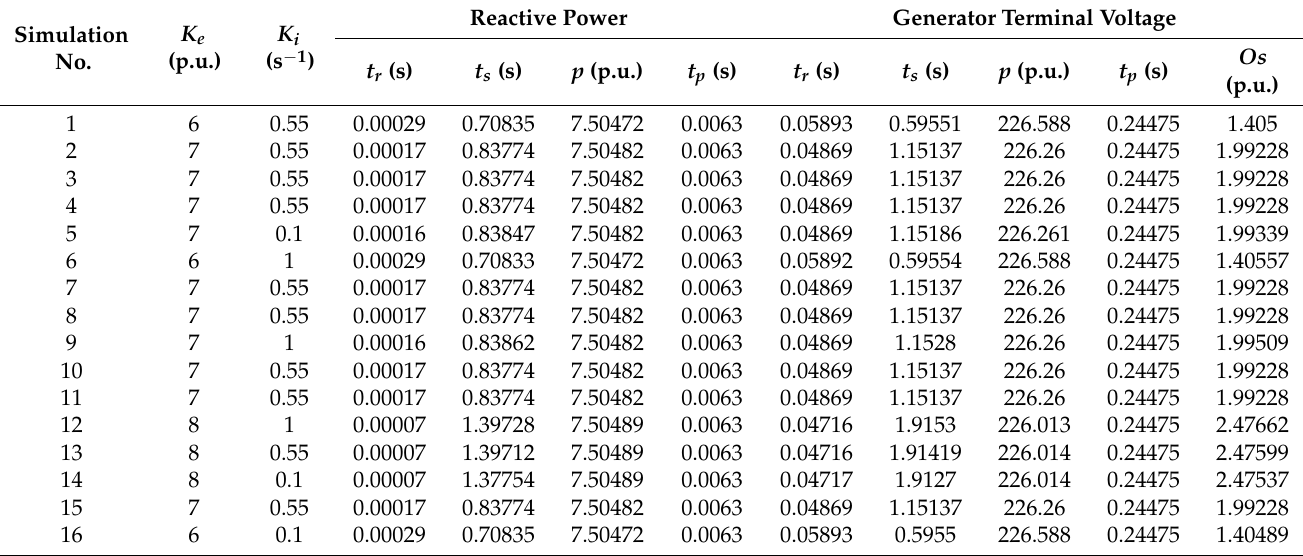
Table 4. The statistics of dynamic performance indexes of the reactive power and generator terminal voltage. Simulation